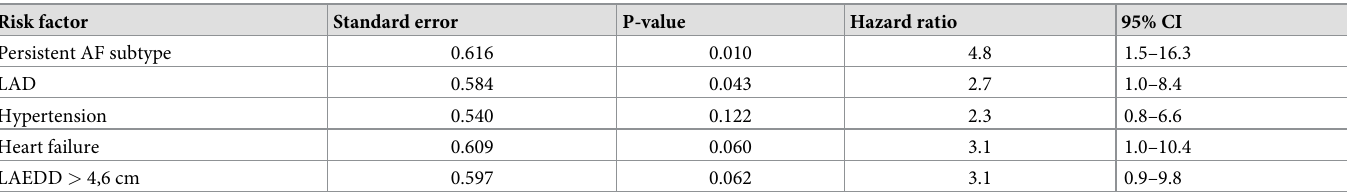
Table 2. Binary logistic regression to determine independent predictors of AF